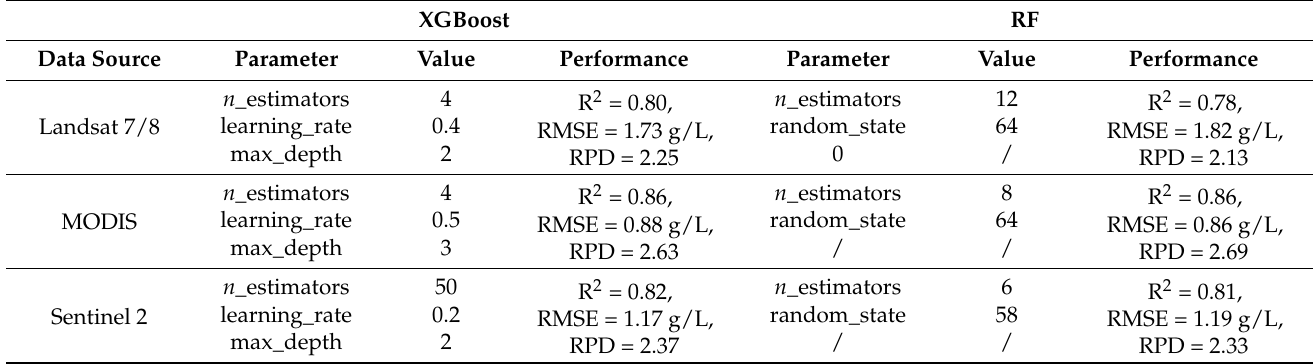
Table 2. Parameters and performance of the two optimal inversion models.